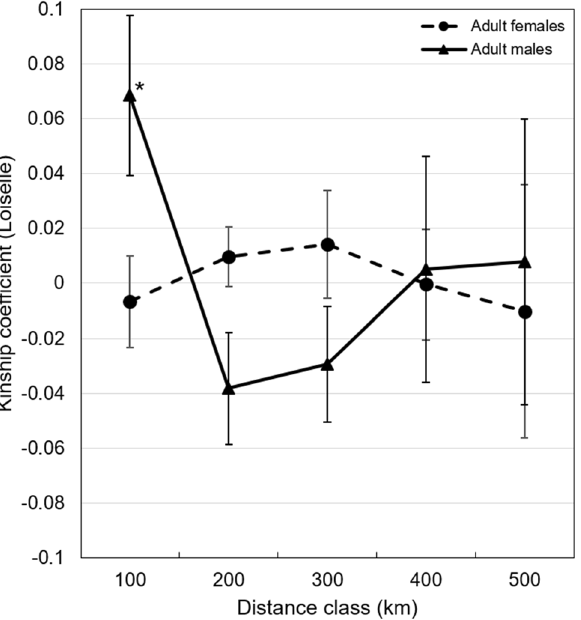
Figure 2. Results of the isolation-by-distance analysis among adult female and male Mediterranean monk seals in Greece. Distance classes that differed significantly ( P < 0.05) from the mean kinship of the population are marked with an asterisk